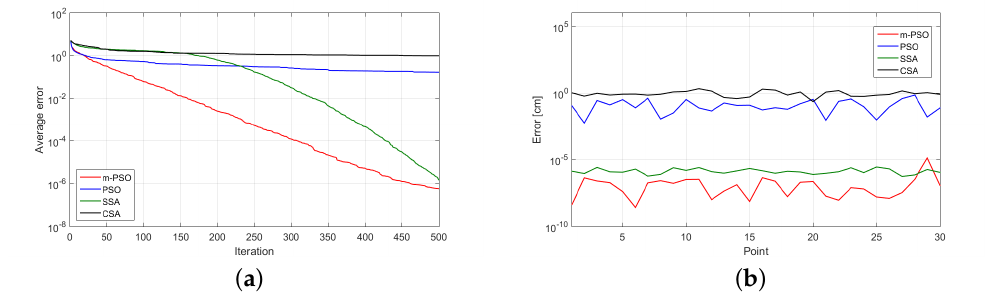
Figure 8. ( a ) Comparative mean fitness evolutions of m-PSO, PSO, CSA, and SSA. ( b ) Comparative position errors over 30 tests of m-PSO, PSO, CSA, and SSA.